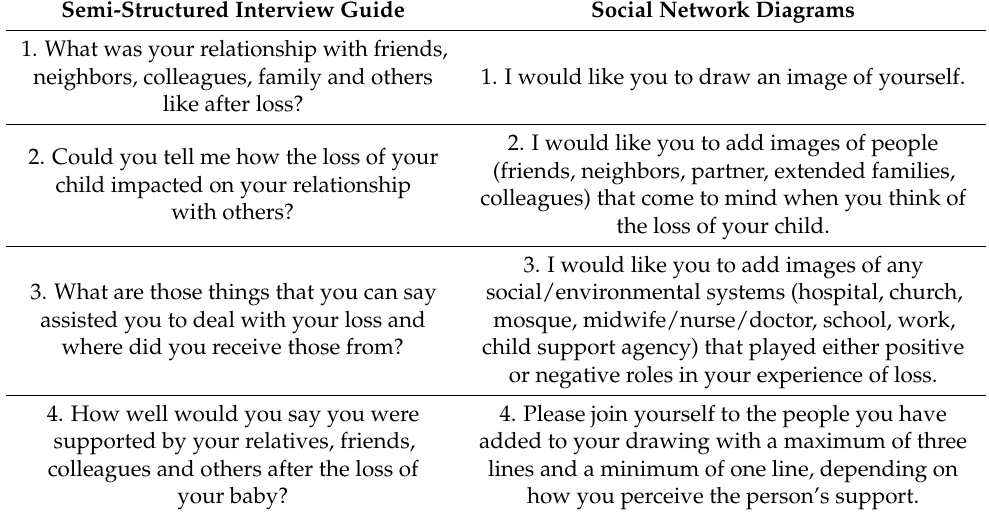
Table 2. Interviews and diagrams’ instructions. Semi-Structured Interview